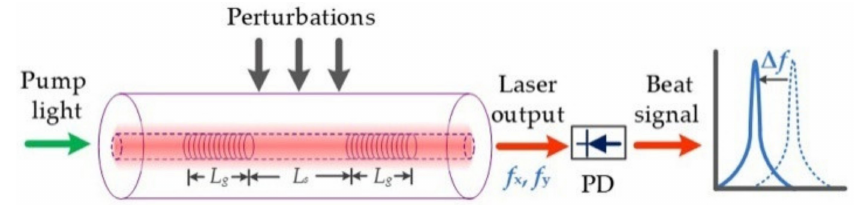
Figure 1. Principle of the dual-polarization fiber laser ultrasound sensor. PD,